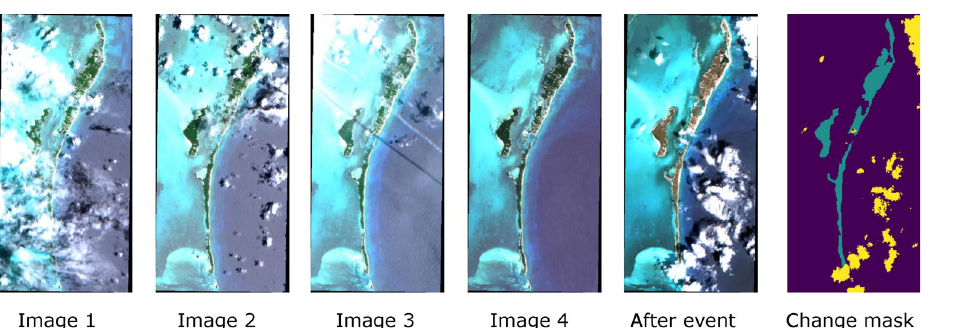
Figure 2. Example of validation sample—in this case, a hurricane event—and its corresponding ground-truth mask (which contains labels of change and clouds).